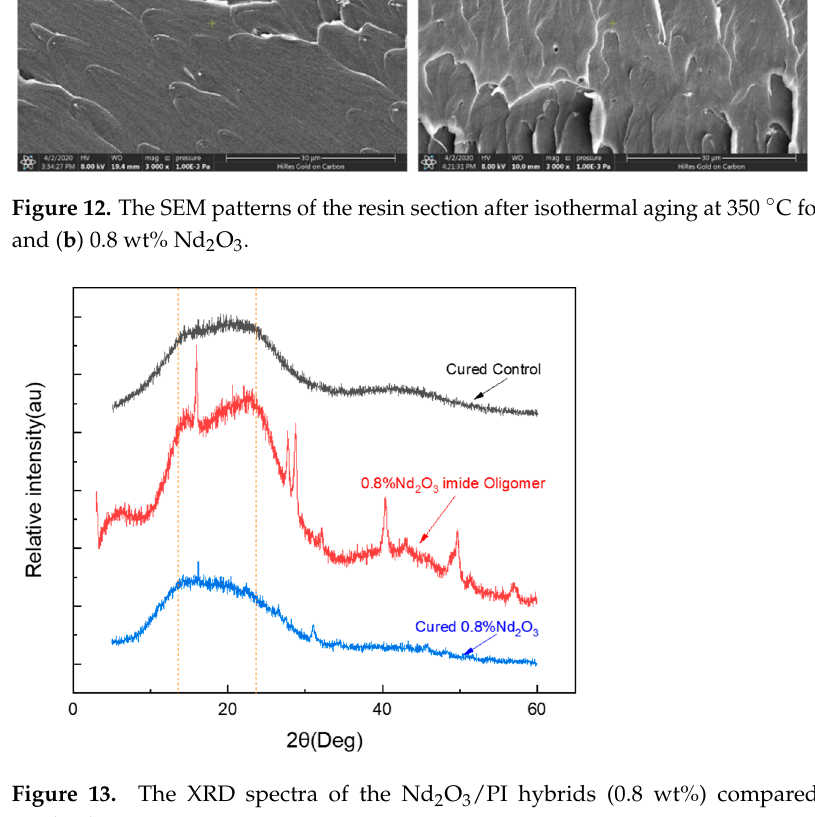
Figure 13. The XRD spectra of the Nd 2 O 3 /PI hybrids (0.8 wt%) compared to the modified imide oligomer.